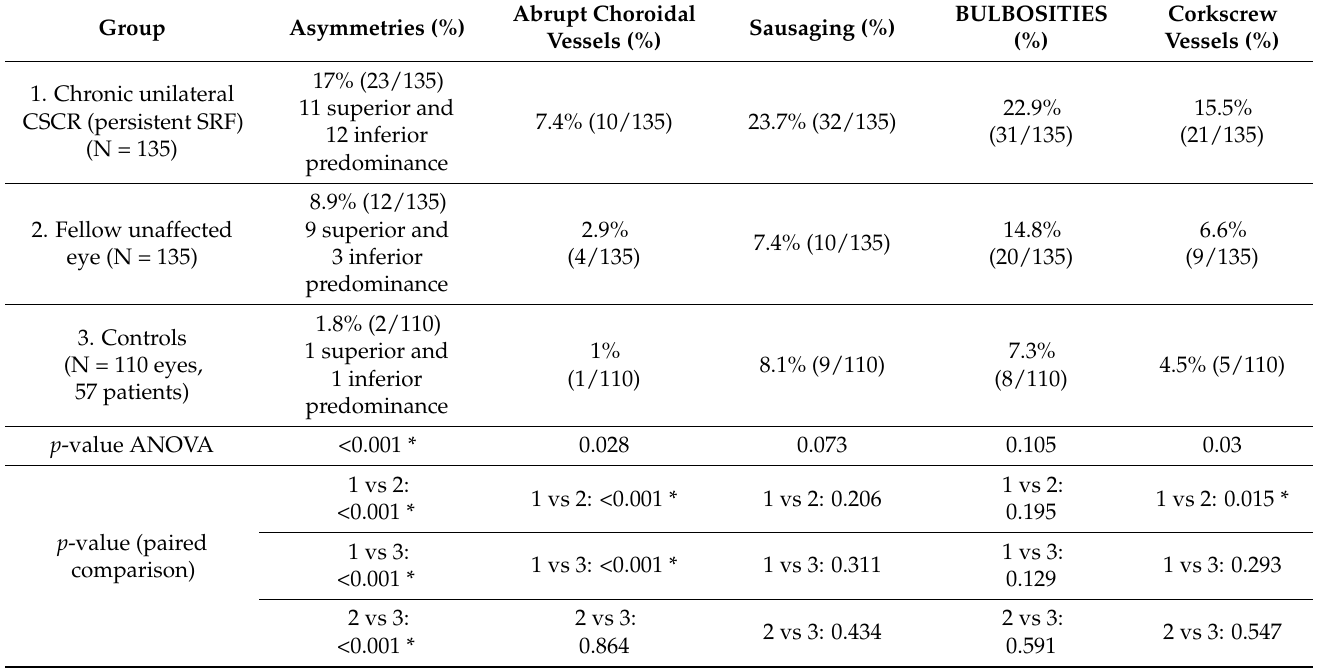
Table 3. Summary of the main characteristics of the choroidal vessels assessed by En Face optical coherence